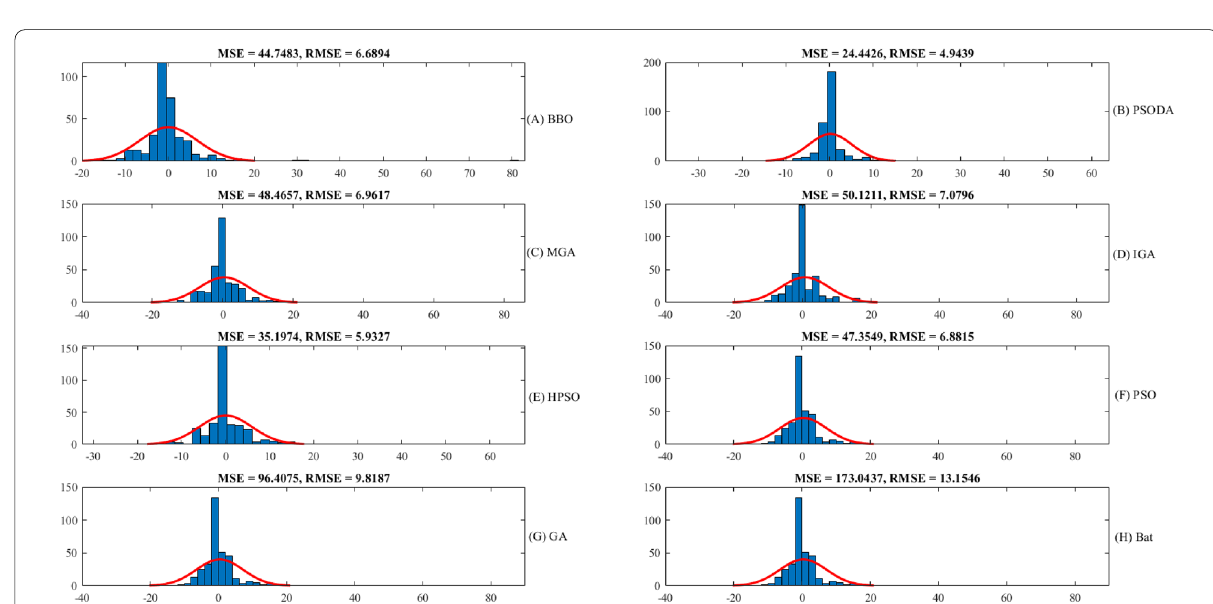
Fig. 13 MSE and RMSE values of different methods for training